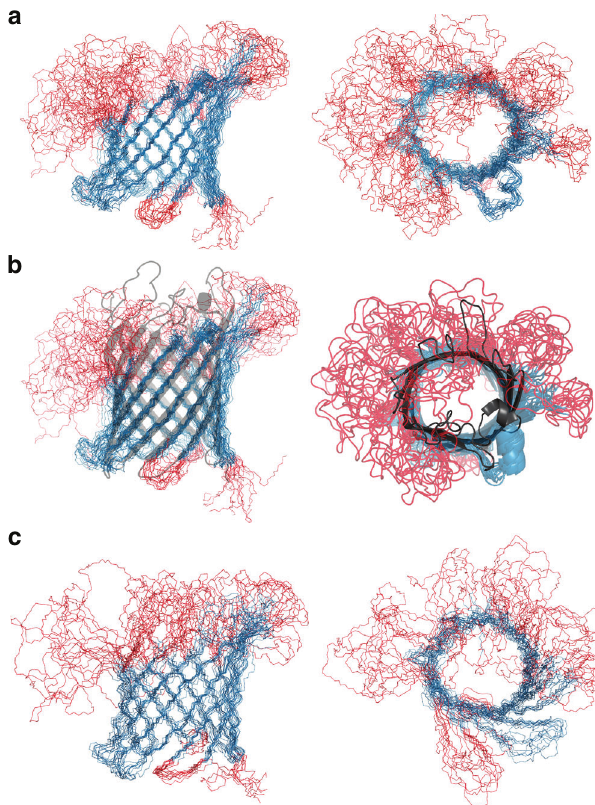
Fig. 3 Solid-state NMR structure of OmpG in lipid bilayers and comparison to X-ray and solution NMR structures. a Regular secondary structure is shown in blue, loop regions in red. The structures to the right are turned by 90°. b Overlay of solid-state (blue and red) and X-ray structure (dark gray). The beta-sheet is extended further in the model derived by X-ray crystallography (2IWV), see left edge. c Same views of the solution NMR structure 2JQY obtained from OmpG solutions in dodecylphosphocholine. Figure generated using pymol 53